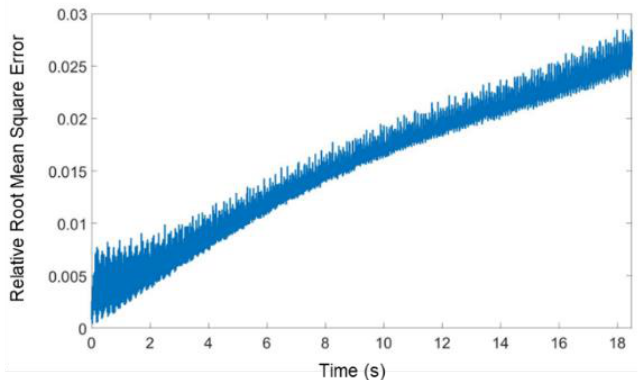
Figure 11. Example 2: RRMSEs of the proposed method from OpenFOAM.